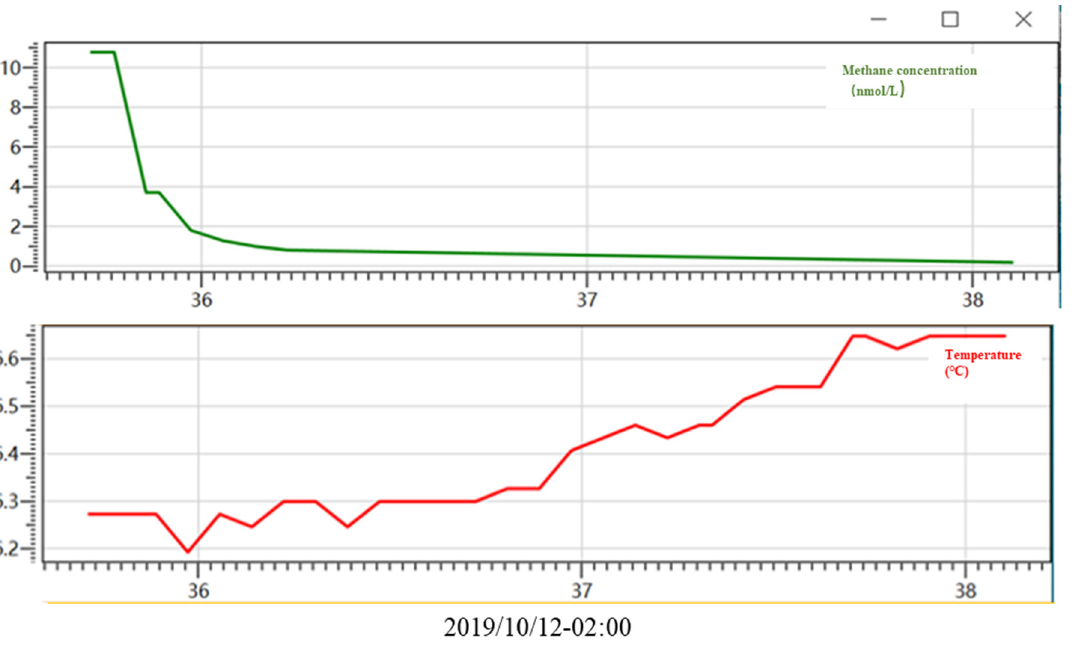
Figure 7. Test data at a water depth of 500 m (18,260–18,265 sound communication module paired successfully). (3) The operating frequency was 30 s at a water depth of 1250 m, and the test time was 10–20 min. The test results showed that the communication was normal, and the data were successfully received. As shown in Figures 8–10.